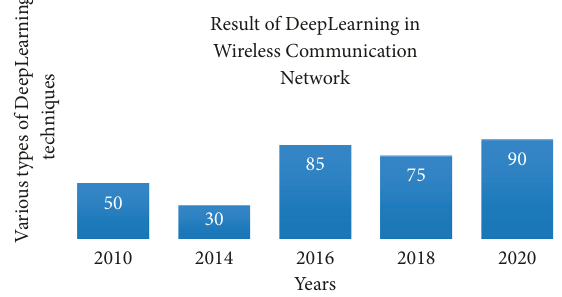
Figure 2: Result of deep learning in